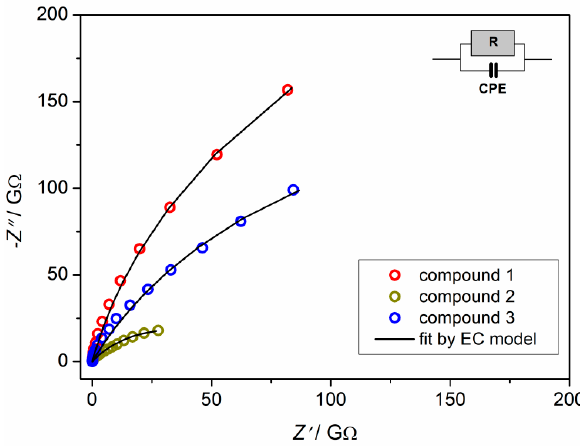
Figure 12. Complex impedance plot and corresponding equivalent circuit (EC) for compounds 1 – 3 at room temperature.